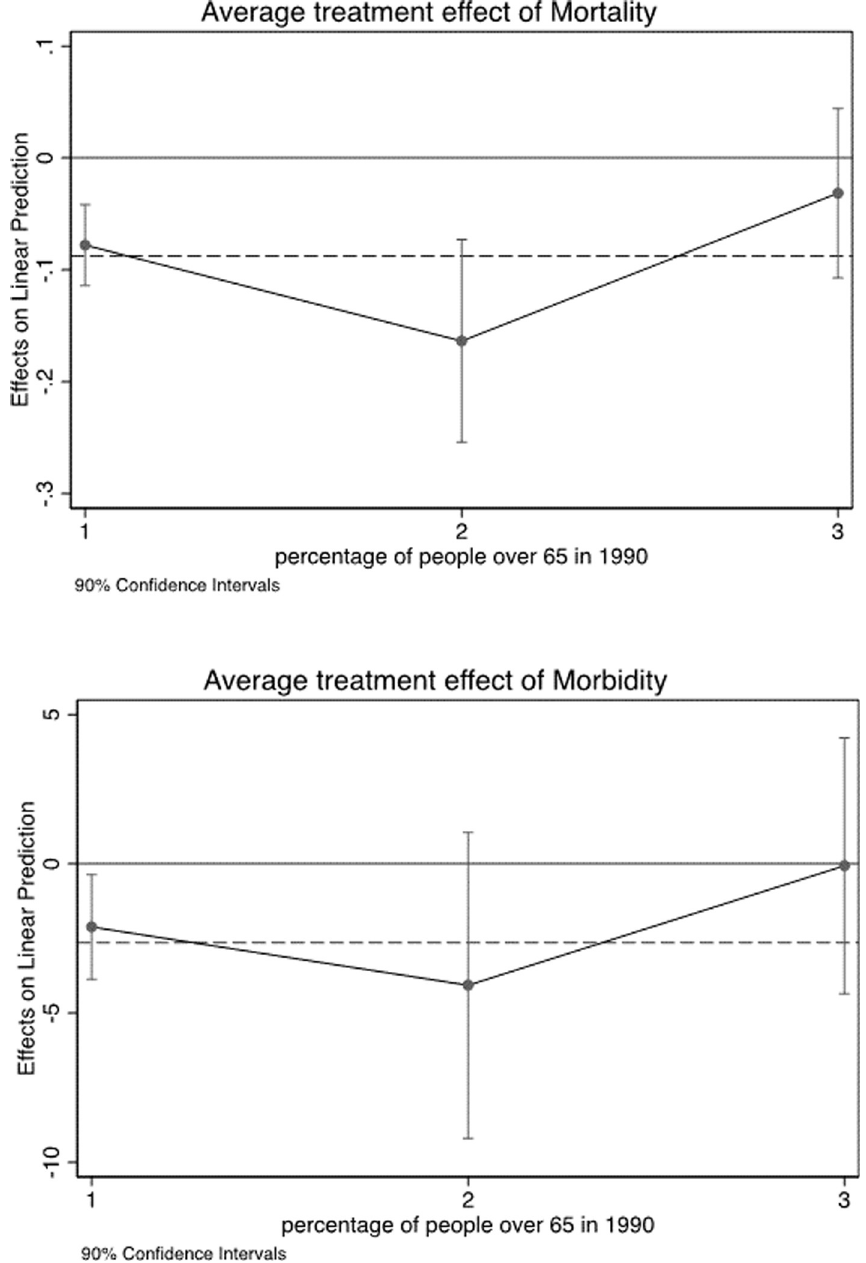
Fig 3. Heterogeneous effects by WB percentage of people over 65 in 1990. Note: Average treatment effects for countries whose percentage of people over 65 in 1990 is below 5% (group 1), above or equal 5% and below 10% (group 2), and 10% or more (group 3),. Average treatment effects for the full sample (dotted